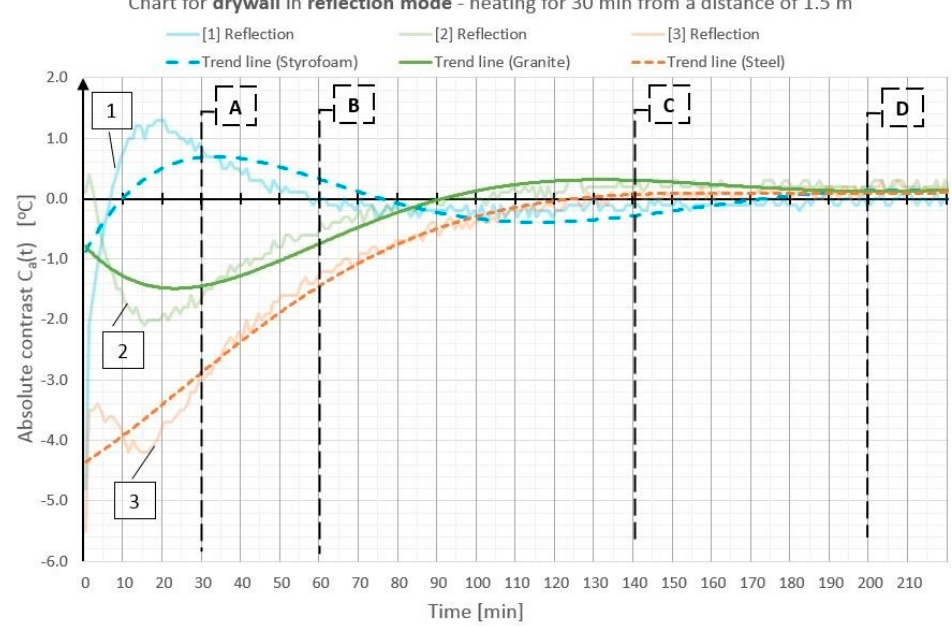
Figure 8. Diagram of absolute contrast for measuring in the reflection mode for a GB partition model with heating from a distance of 1.5 m (based on thermograms in Figure 3, row V).